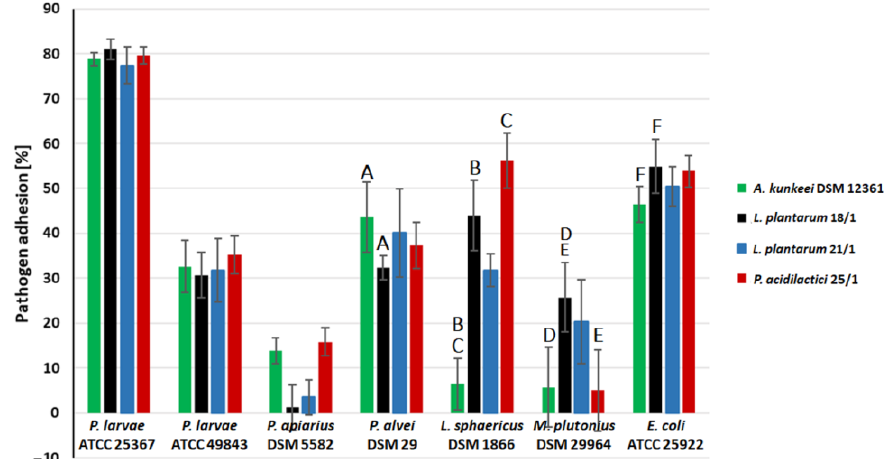
Figure 5. Effect of cell-free supernatants (CFSs) from lactic acid bacteria (LAB) on pathogen adhesion [%] to polystyrene after 1 h incubation. Each data point represents the mean from eight individual wells. The average absorbance of each pathogen incubated without CFSs was taken as 100%. Results are presented as mean ± standard deviation (SD). Statistically significant differences in the LAB effect on biofilm formation of honeybee pathogens are indicated on the chart with a letter, p -value as follows: A — p = 0.014; B — p = 0.004; C — p = 0.00004; D — p = 0.0053; E — p = 0.048; F — p = 0.0047.